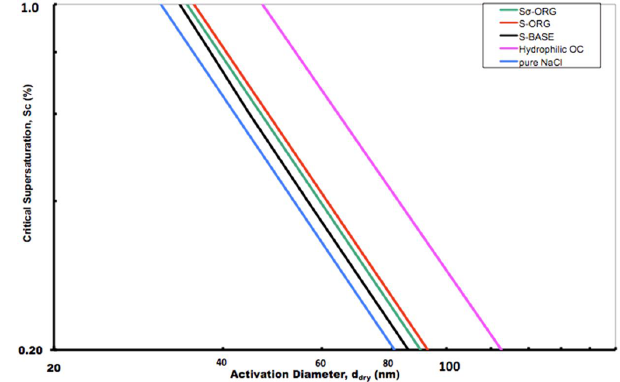
Fig. 5. S c (critical supersaturation) versus D dry (dry aerosol diam- eter) plot for modeled marine aerosols in Southern Ocean (45 ◦ 0 0 S, 0 ◦ 0 0 E). The black line represents model results for base case ma- rine aerosols (no marine organic emissions). The green and red lines represent model output for organically enhanced marine aerosols with and without surface tension depression effects included. The magenta and blue lines represent pure species of hydrophilic OC and sea salt, respectively, and provide a frame of reference for our model